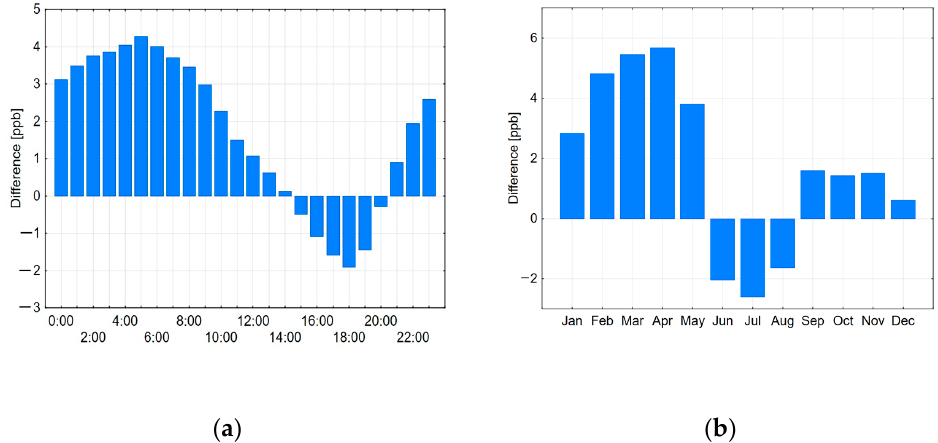
Figure 5. The differences between surface O 3 measured at Belsk and Racibórz (ppb), from 2018 to 2021, for diurnal ( a ) and monthly ( b ) scales.